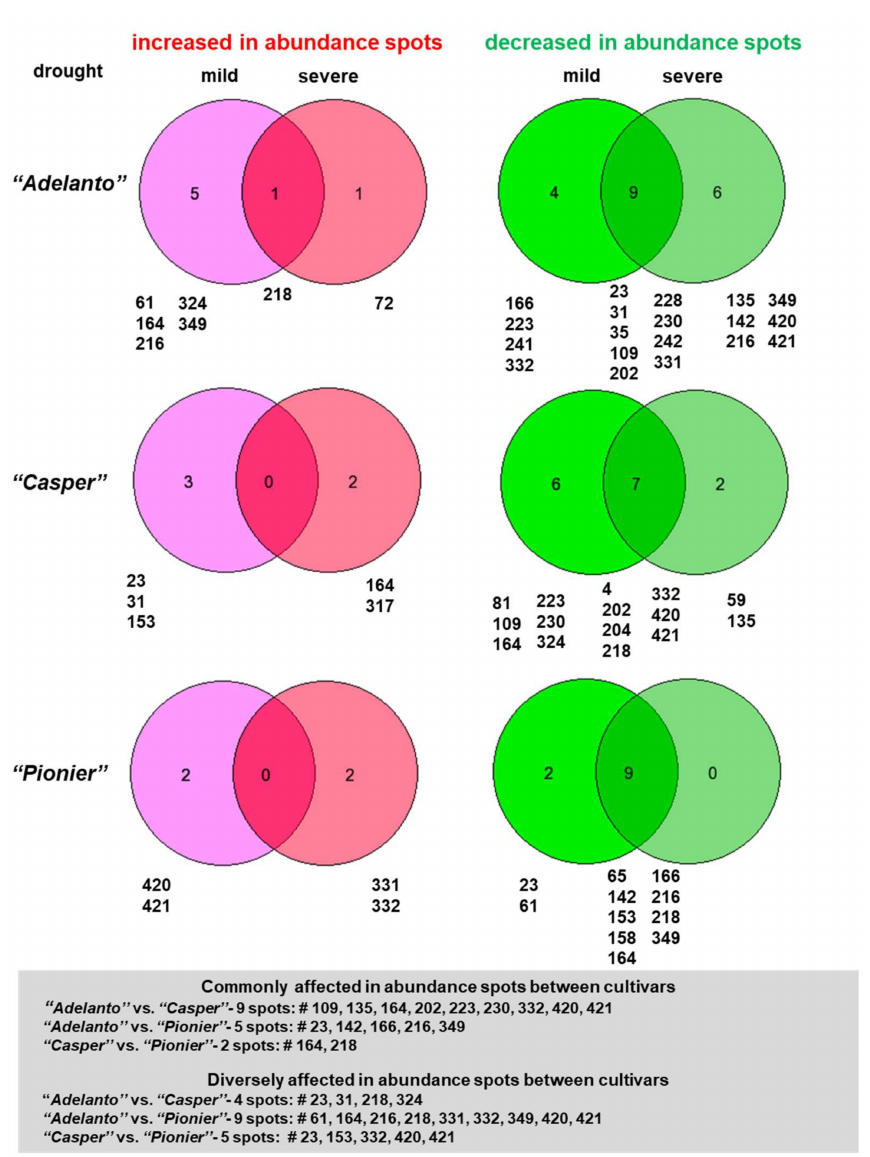
Figure 2. Venn diagrams showing distribution of increased and decreased in abundance specific/common protein spots to mild and severe drought across investigated cultivars. Numbers refer to protein spot identifiers. Increased (magenta and pink diagrams) and decreased (light and dark green diagrams) in abundance spots between cultivars are marked below each diagram; commonly and diversely affected in abundance spots are also listed. Further data in the